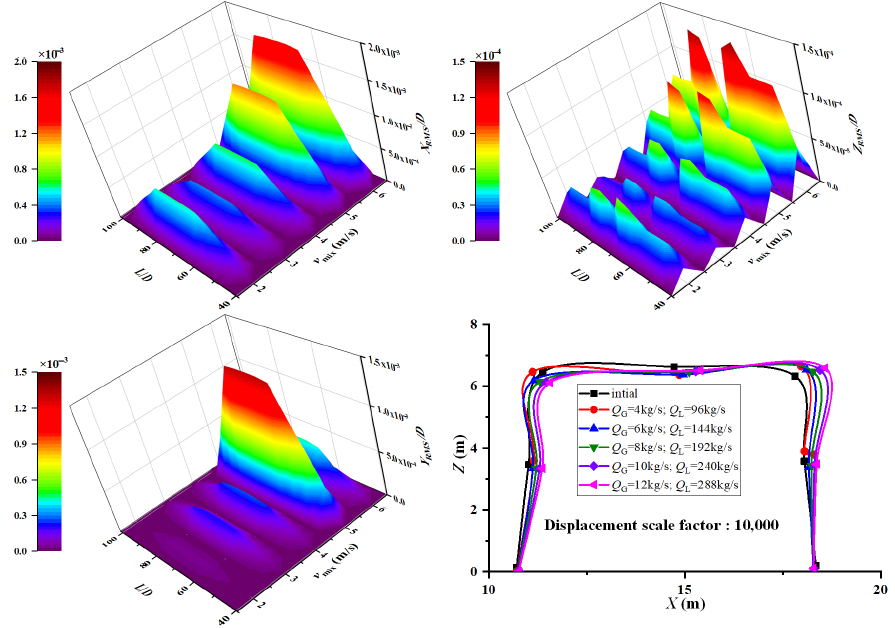
Figure 15. The root-mean-squared displacements along the jumper span and the new equilibrium positions in the in- plane at different inlet mass flow rates.